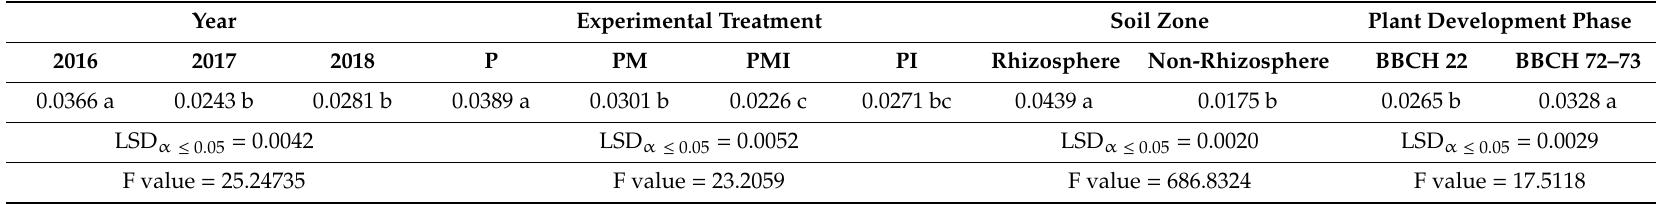
Table 1. Catalase (CAT) activity (mg H 2 O 2 · g − 1 dm · min − 1 ).